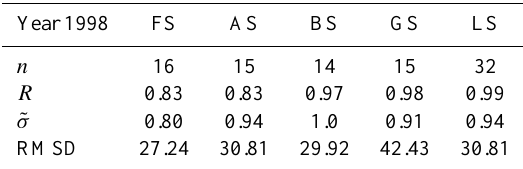
Table 3. Correlation coefficient, R , normalised standard deviation, ˜ σ , and root mean square difference, RMSD [ mmolO simulated and measured oxygen concentrations in the full water col- umn for n days in the year 1998.